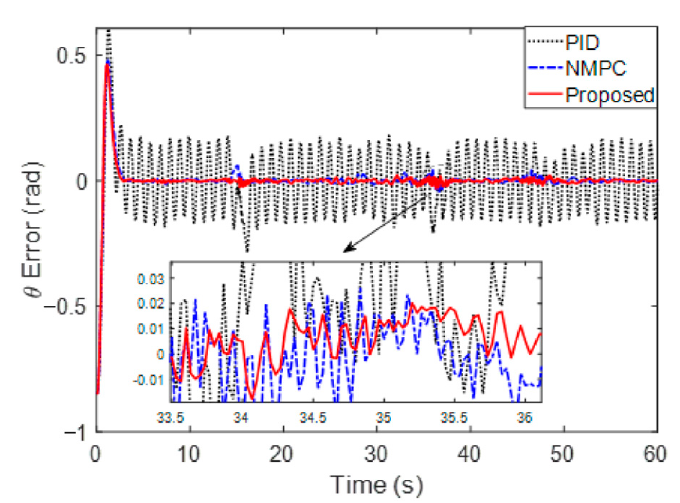
Figure 7. Orientation error of the comparison method.